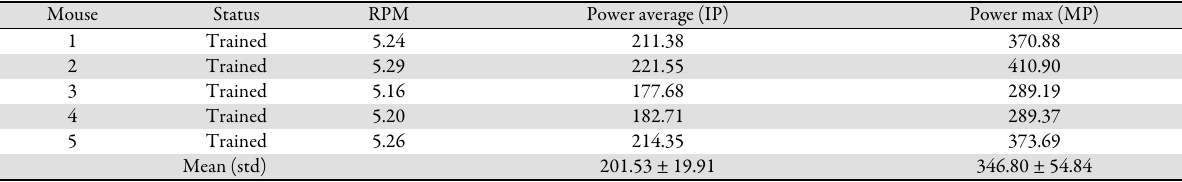
Table 1. Data for the trained group at effort activity for 5 minutes